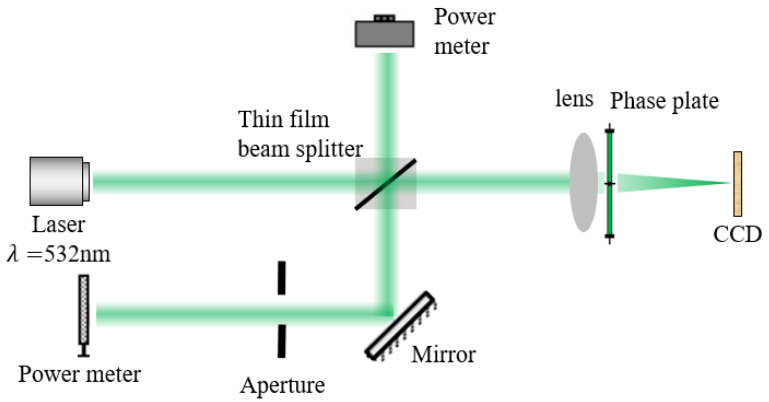
Figure 6. Sketch map of the experimental setup for a laser beam through a cat-eye system. The phase plate is an important component in the wavefront coded imaging system.